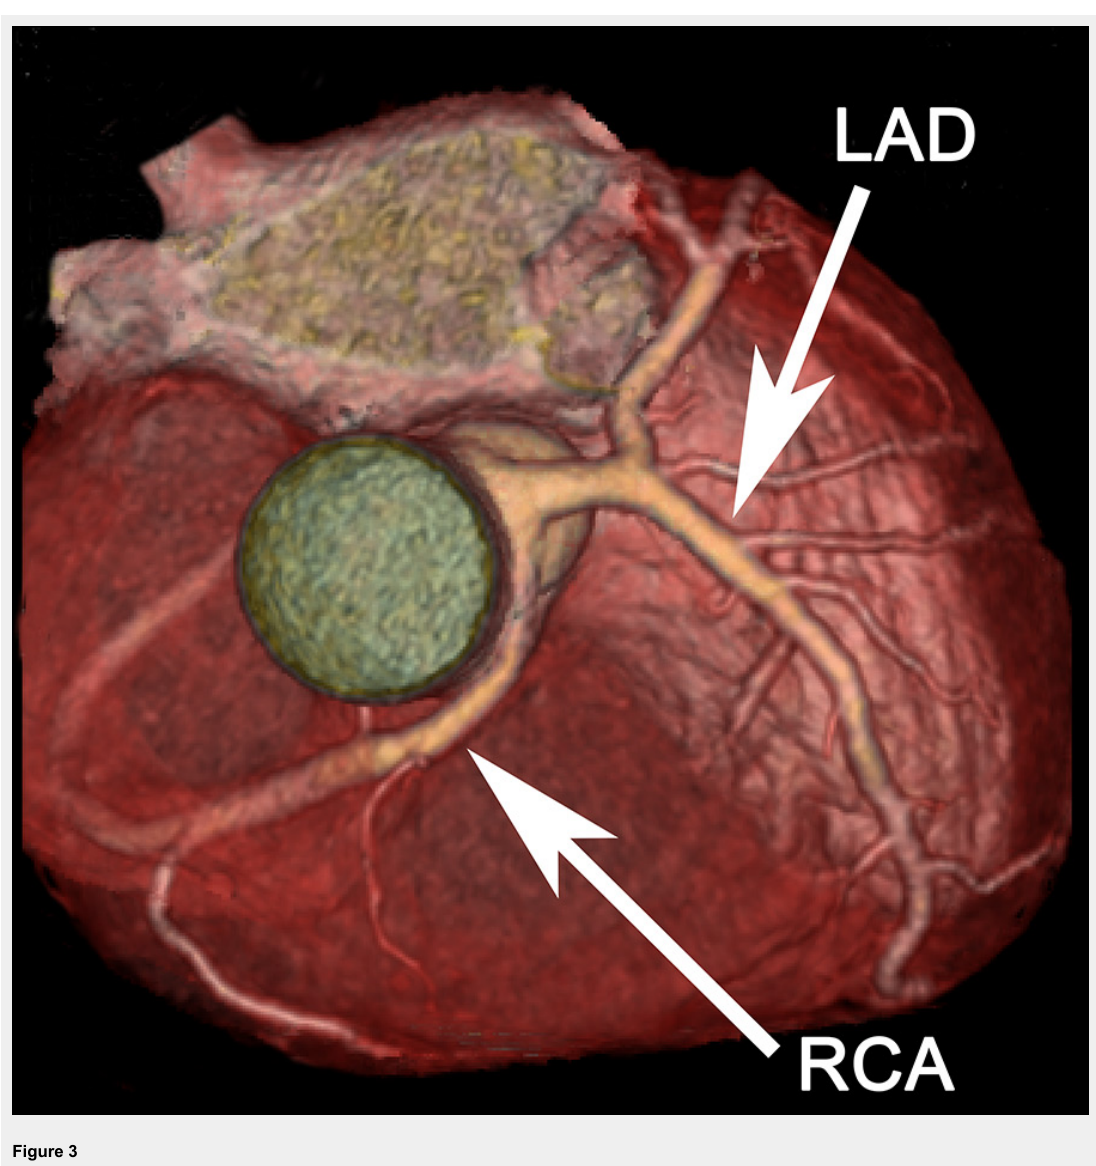
Figure 3 Incidental finding of an ACAOS variant with RCA originating from LCS and a malignant interarterial course of the vessel in a patient referred for CCTA for exclusion of CAD. ACAOS = anomalous coronary arteries originating from the opposite sinus Valsalva; CAD = coronary artery disease; CCTA = coronary computed tomography angiography; LAD = left anterior descending artery; LCS = left coronary sinus; RCA = right coronary